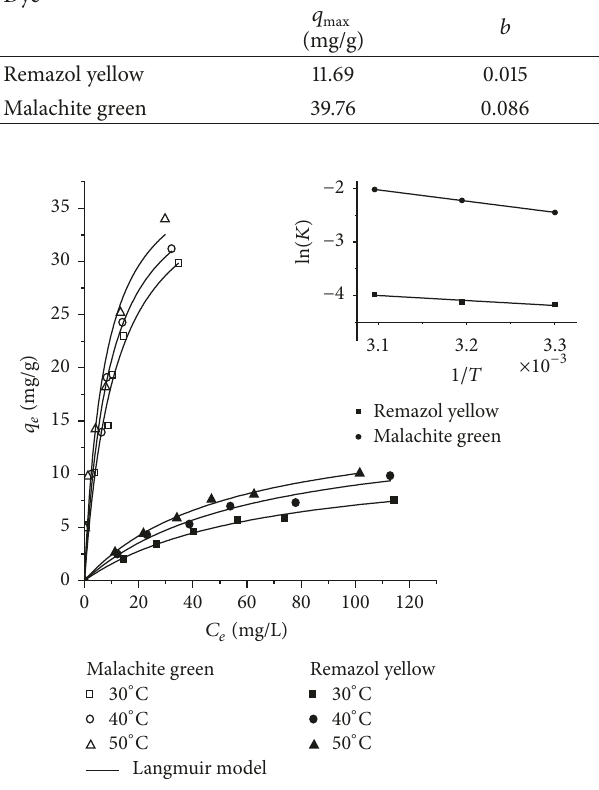
Figure 5: Langmuir model and Van’t Hoff plot for the adsorption of the Remazol yellow and malachite green onto carbonaceous material.